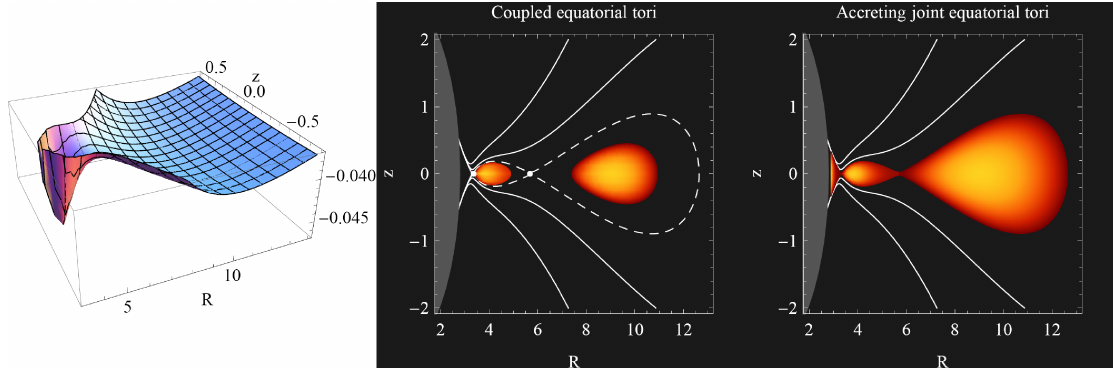
Figure 21. Typical behavior of the potential W for the charged fluid shown in terms of its poloidal profile (left) and poloidal equipotential contours (right). The behavior characterizes circulation of the fluid . = 5.15 and = = 2.6. The twice self-crossing dashed with (cid:96) , in the dipole magnetic field with K A φ M curve determines the critical equatorial lobes with equatorial cusp and pseudo-cusp, corresponding to the equatorial saddle points; the dots denote locations of the cusp and